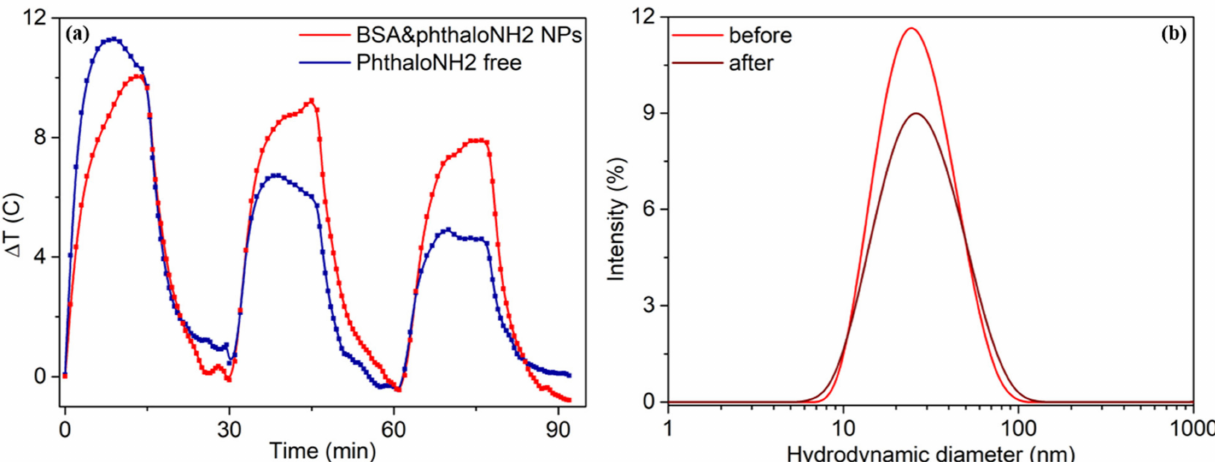
Figure 9. ( a ) The thermal curves of the BSA&phthaloNH 2 NPs (red) and of the free phthaloNH 2 (blue) obtained after three On/Off irradiation cycles. ( b ) The DLS spectra present BSA&phthaloNH 2 NPs’ hydrodynamic diameter stability assay before (red) and after (brown)